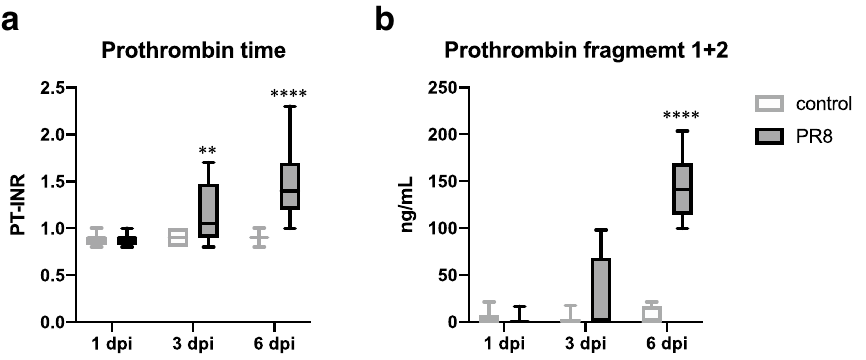
Figure 1. Blood coagulation parameters in control versus PR8 virus-infected mice at 1, 3, and 6 dpi. Mice were intranasally inoculated with PBS control or PBS comprising PR8 virus, and whole-blood and serum samples were collected for the measurement of ( a ) PT-INR [n = 11 (PR8-6 dpi group) or 12 (the other groups)] and ( b ) prothrombin fragment 1 + 2 [n = 6 (PR8-6 dpi group) or 8 (the other groups)], respectively, at 1, 3, and 6 dpi. ( a and b ) Values are represented by box-and-whiskers plots as follows: the central line in the box is the median, the bottom and top lines of the box are the first and third quartiles, respectively, whiskers are the minimum to maximum values. In each panel, white and gray boxes indicate data from control and PR8 virus-infected mice at 1, 3, and 6 dpi, respectively. ** p < 0.01, **** p < 0.0001, two-way ANOVA using a multiple-comparison correction, control versus PR8 virus-infected mice at each time point. PT-INR, international normalized ratio of prothrombin time; PR8, influenza virus A/Puerto Rico/8/34; dpi, days